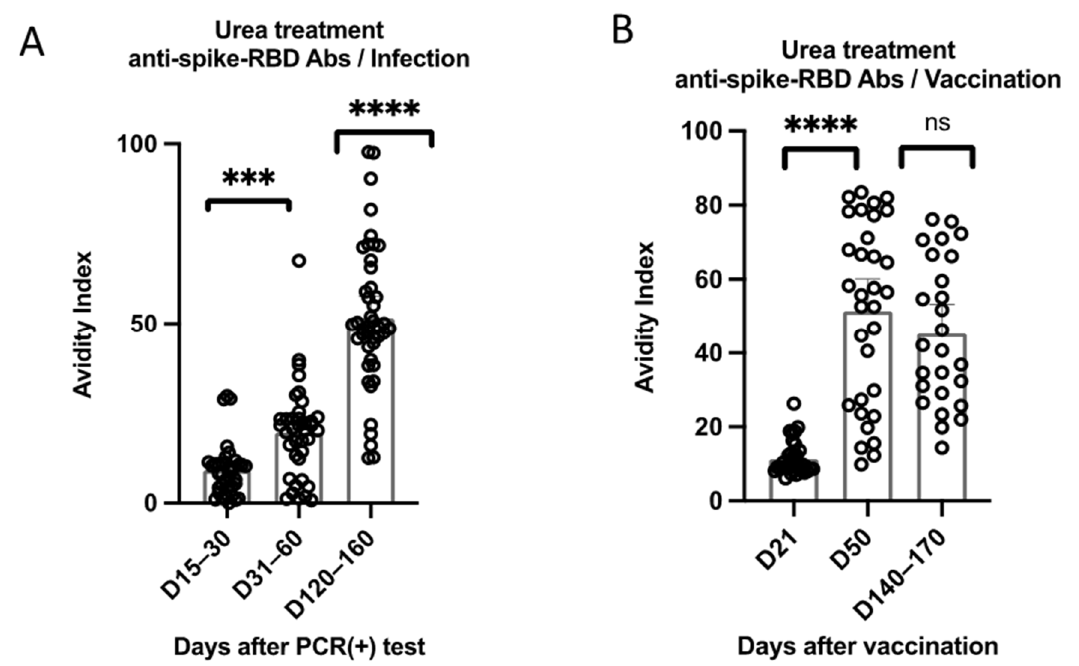
Figure 3. Kinetics of anti-RBD antibody avidity in ( A ) SARS-CoV-2 convalescent and ( B ) immunized individuals. Avidity measurements were based on the urea dissociation of low-avidity antigen- antibody complexes, using the previously described ELISA protocol, with the modification of washing steps by using 200 μ L of 6 M urea diluted in PBS. Avidity Index (AI%) was expressed as follows: AI% = (OD mean value from urea treated sample divided by the OD mean value from the non-treated) multiplied by 100. *** p < 0.001, **** p < 0.0001, ns: not significant.